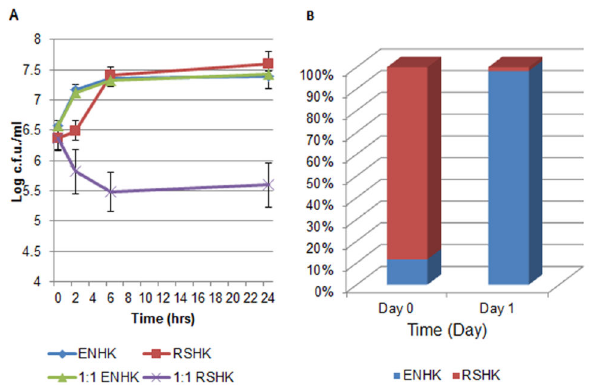
Figure 9. Antagonistic activity of E. cloacae subsp. cloacae ENHKU01 against R. solanacearum . Figures show results of ENHKU01 – R. solanacearum competition